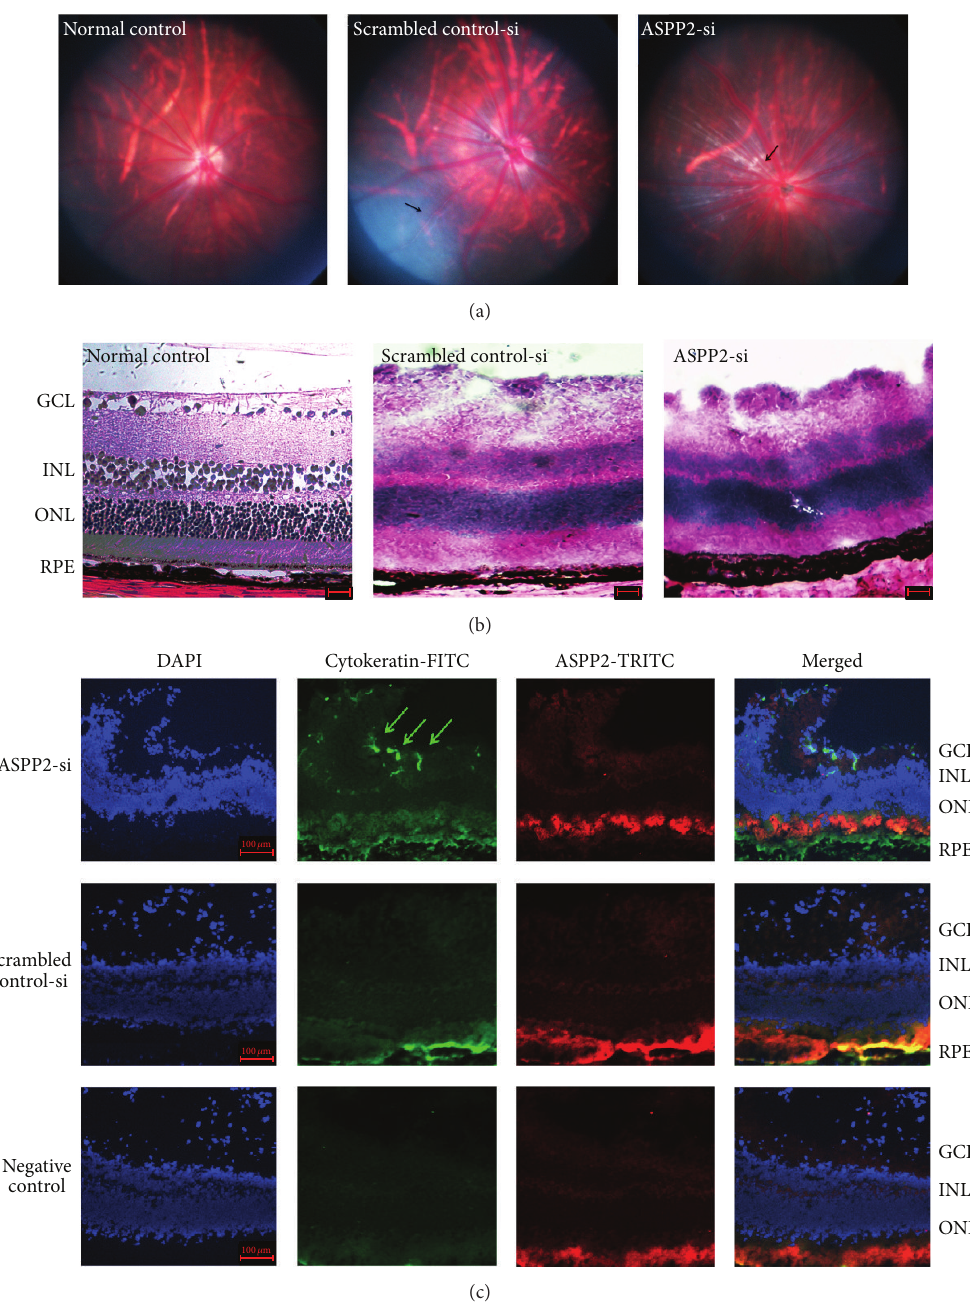
Figure 6: Effects of ASPP2 on retinal morphological changes of experimental PVR. Color fundus photographs of BN rats at 14-day follow- up (a). Fibrous proliferation was observed in both the scrambled control-siRNA treatment group and the ASPP2-siRNA treatment group, as indicated by the black arrows. Hematoxylin and eosin staining of retinal sections were performed at the 14-day follow-up (b). The swelling and proliferation of the ganglion cell layer in the scrambled control-siRNA and ASPP2-siRNA treatment group were apparent when compared to the normal control group. Scale bars, 50 𝜇 m. Immunohistochemical staining of the retinal sections of the BN rats at the 14-day follow-up (c). Fluorescence micrograph showing that cytokeratin expression (green) existed in the ganglion cell layer of the ASPP2-siRNA treatment group (green arrows) but not in the scrambled control-siRNA treatment group or the negative control group. However, ASPP2 expression (red) was not colocalized with the cytokeratin expression in the ganglion cell layer in the ASPP2-siRNA treatment group, indicating the knockdown efficacy of ASPP2-siRNA treatment in vivo . Cell nuclei were stained with DAPI. Representative results obtained in at least three independent experiments are shown. DAPI, 4 󸀠 ,6 󸀠 -diamino-2-phenylindole. Scale bars, 100 𝜇